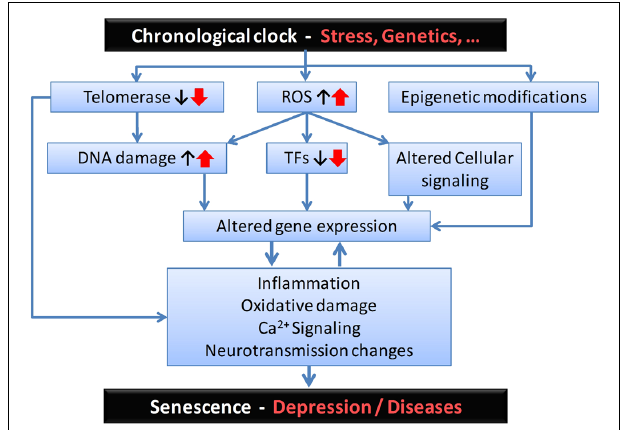
FIGURE 2 | Proposed sequence of biological events and putative mediators for the age-by-disease biological interaction hypothesis. From the top : Although its biological substrates are unknown, a chronological clock drives age-related changes in gene expression.These changes can be exacerbated by psychophysiological stress and/or genetic variants, and placed on accelerated age trajectories. In this model, age-related changes in telomeres, oxidative load and epigenetic landscape, among other putative mechanisms, may represent a first level of biological events, which in turn affect basic cellular processes involved in regulating gene expression (i.e., including DNA damage, altered structure and function of transcription factors (TFs), and associated local cellular signaling).The resulting changes in the global pattern of age-dependent gene expression mediate the next set of deleterious biological events, exemplified here by increased inflammation, oxidative damage-related signaling, and changes in neurotransmission.These two levels of changes are likely to reciprocally interact. At the neural network and brain levels, the emerging properties of those specific cellular events are expressed as senescence in normal aging subjects and, in subjects at risk, as age-related symptom dimensions and diseases, including depression. Notably, the degree of individual vulnerability is thought to be under genetic and environmental control, so decreased vulnerability may mediate resiliency through the same